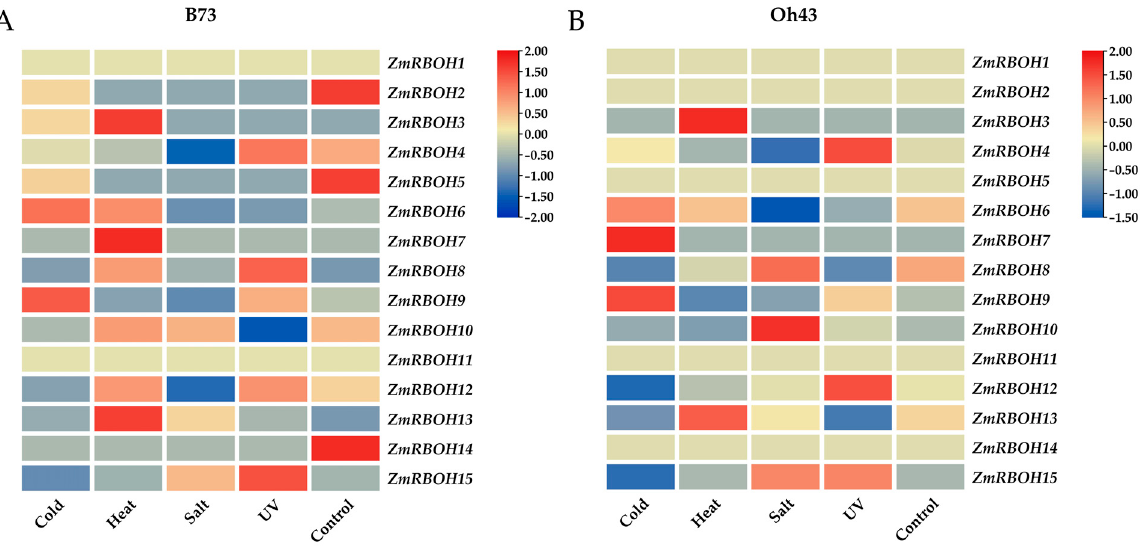
Figure 7. Expression profiles of ZmRBOH genes under abiotic stress. ( A ) Expression of ZmRBOH genes in maize inbred line B73. ( B ) Expression of ZmRBOH genes in maize inbred line Oh43. Colors represent log2-fold change comparing relative expression, color scale is provided. Red: high expression level; blue: low expression level.